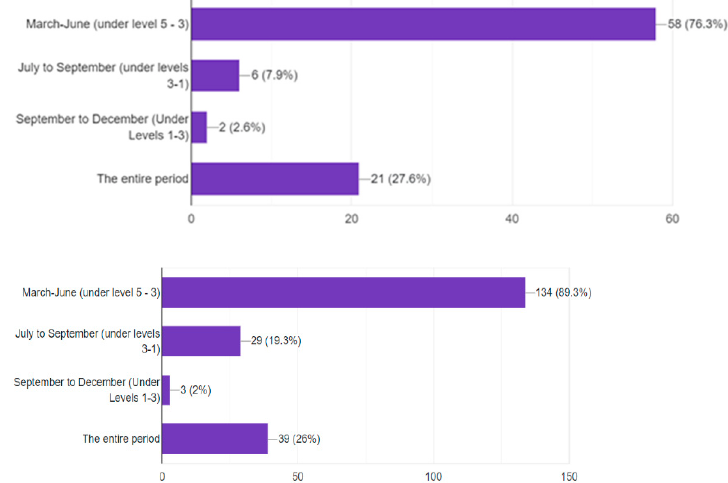
Figure 4. Hardest period for business in KwaDukuza and eThekwini. Source: Author’s own com- putation.